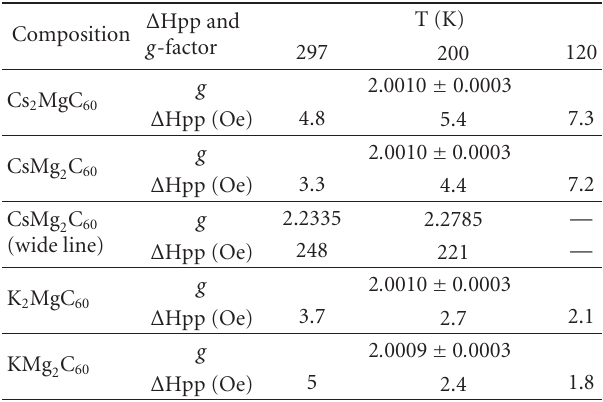
Table 2: Average line width Δ Hpp and g -factor of EPR for non- superconducting fullerides of Cs and